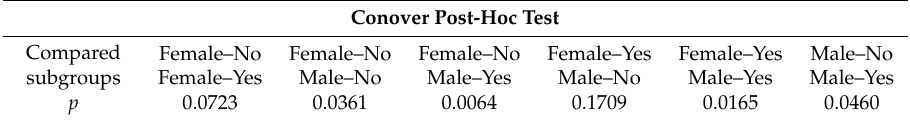
Table 4. Self-reported feeling of anxiety level vs. gender: continuity of clinical work. Conover post-hoc, significant results in bold.